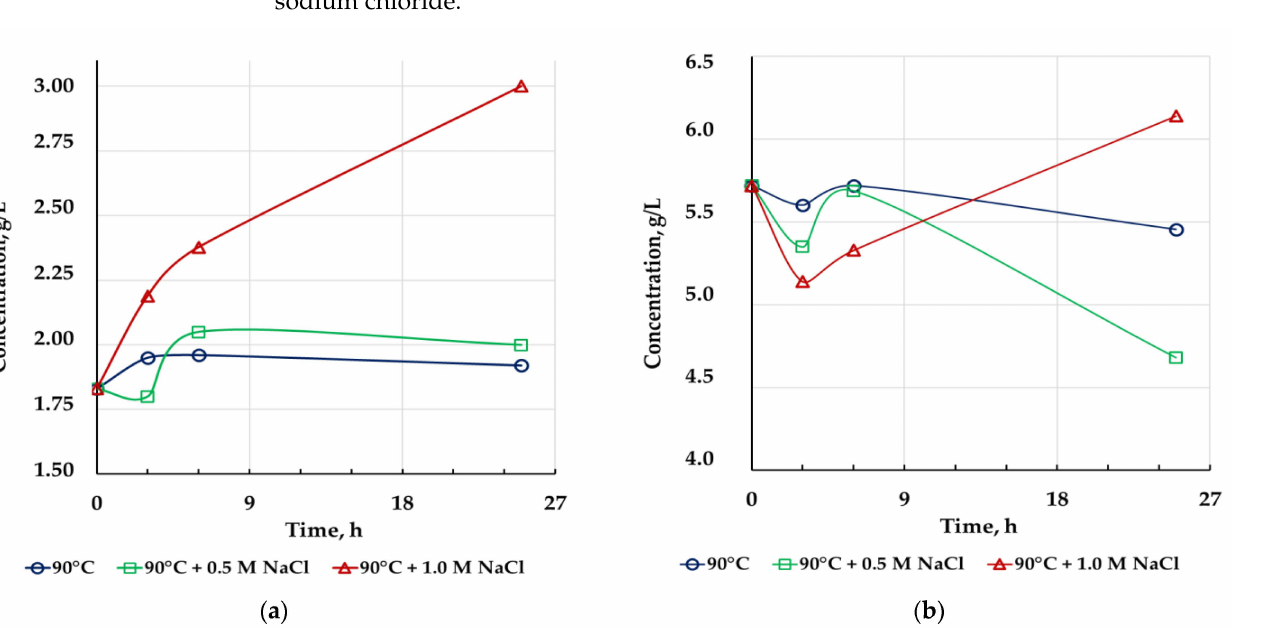
Figure 3. Changes in copper ( a ) and zinc ( b ) concentrations during chemical leaching of bioleaching residues under different